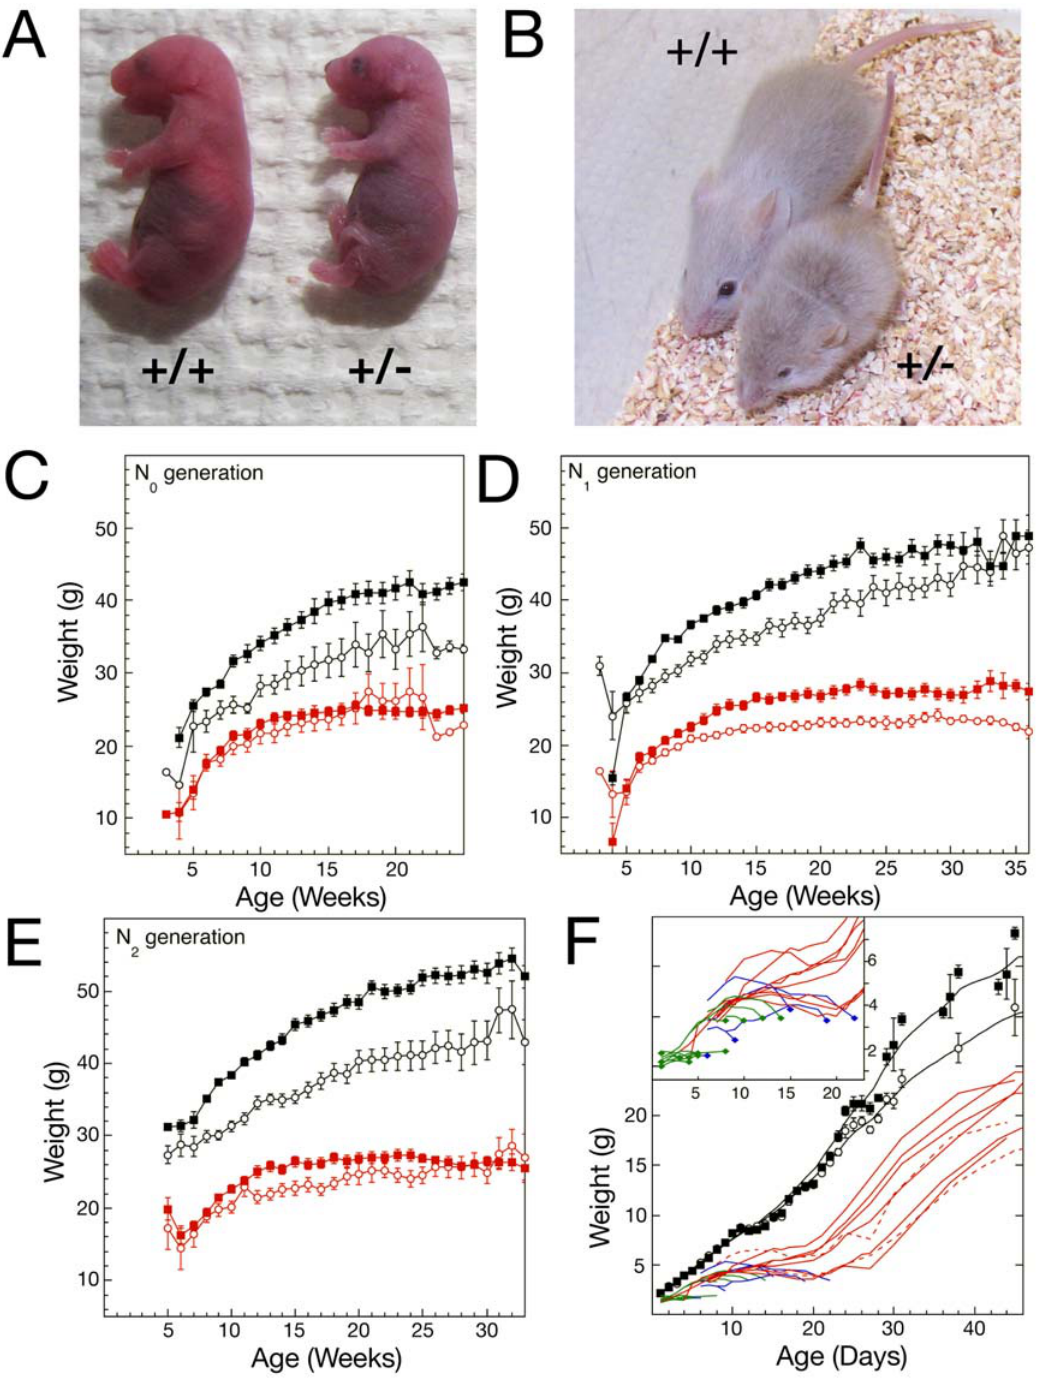
Figure 2. Growth of Nipbl + / 2 mice. (A,B) Photographs of pairs of newborn (A) and 4 week old (B) wildtype and Nipbl + / 2 littermates, illustrating obvious growth retardation. (C–E) Growth curves for N 0 (C), N 1 (D), and N 2 (E) generations, starting at weaning age. Data are pooled by genotype andsex (N 0 wildtype: 15 males and 7 females; N 0 Nipbl + / 2 : 12 males and 7 females; N 1 wildtype 39 males and 28 females; N 1 Nipbl + / 2 : 23 males and 17 females; N 2 wildtype: 72 males and 38 females, N 2 Nipbl + / 2 : 39 males and 23 females): filled squares=male, open circles=female; red symbols= Nipbl + / 2 , black symbols=wildtype; error bars=SEM. Mutant mice of both sexes are smaller, and exhibit less weight gain after maturity. (F) Growth from birth through 6 weeks. Wildtype data (black symbols and lines) are pooled by sex: filled squares=male, open circles=female (data from 28 females and 26 males. error bars=SEM). The records of individual Nipbl + / 2 mice (N 2 and N 3 generation) are shown as connected lines without symbols. Red lines represent individual animals that survived at least 6 weeks (dashed=female; solid=male). Blue lines are Nipbl + / 2 mice that died before weaning. Green lines represent additional mice that died before weaning for which genotype could not be established (due to cannibalism or tissue decomposition). The inset magnifies the pre-weaning interval (1 to 22 days). Whereas wildtype mice grow at a nearly linear rate during the first two weeks of life, the data show that growth of most mutant mice arrests between postnatal days 5 and 15, followed, in about a third of cases, by death several days later. Several of the mutants that stopped growing and lost weight after day 12, however, were able to resume rapid weight gain immediately after weaning.